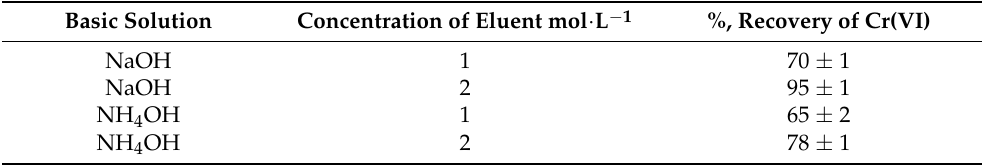
Table 4. Influence of various alkaline solutions, used for desorption of Cr(VI) from NPs/rGO/PMMA. Basic